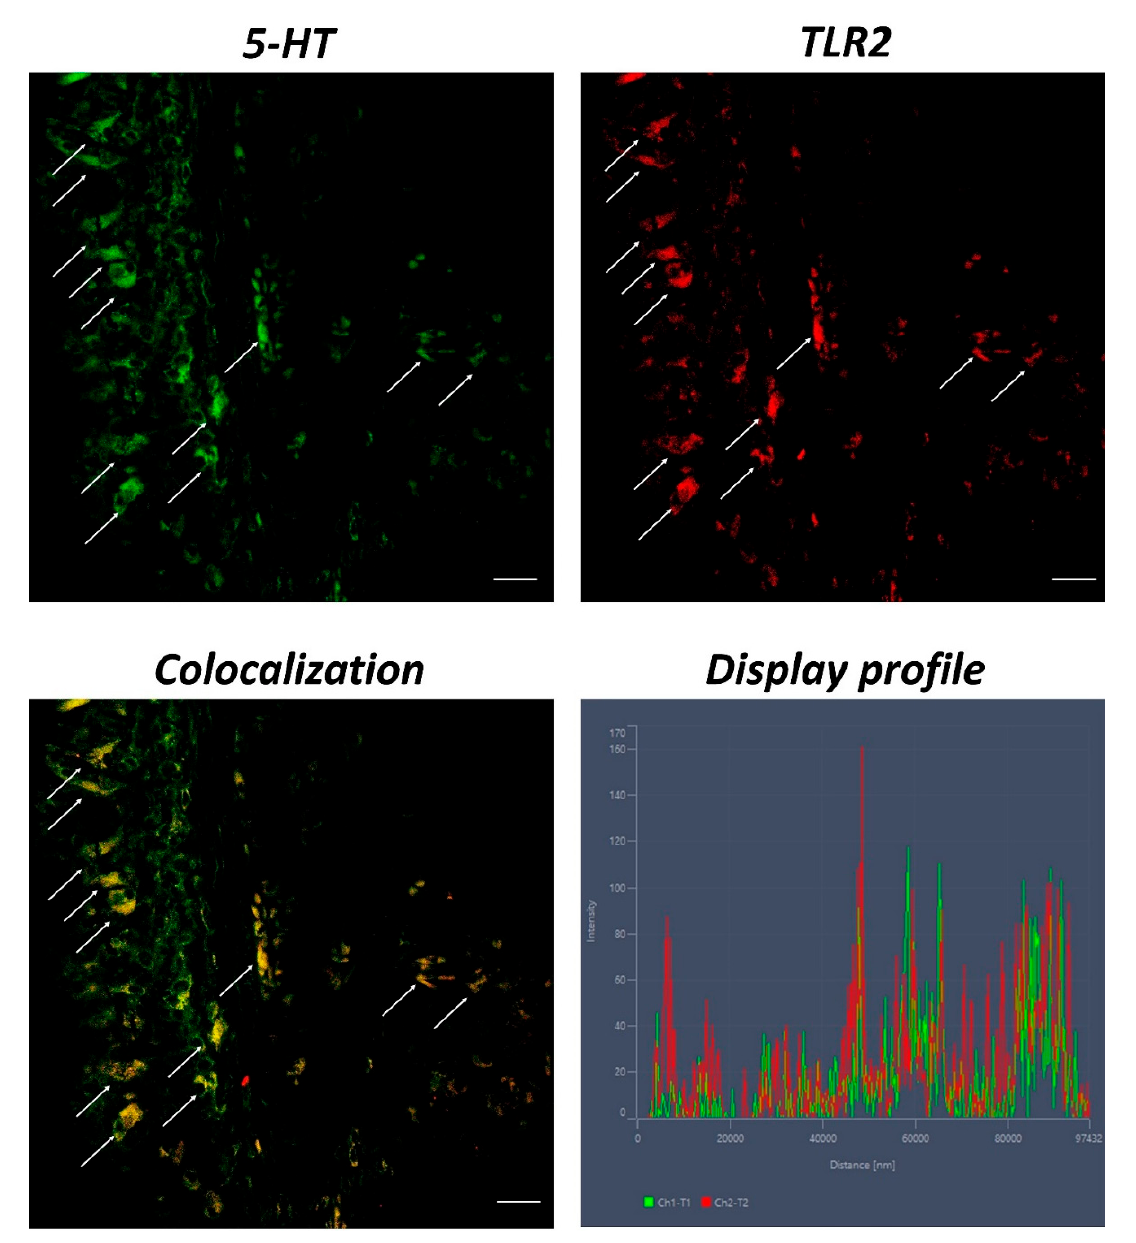
Figure 5. Section of the gill of giant mudskipper, immunofluorescence of 5-HT and TLR2, 40×, scale bar 40 μ m. Scattered MCs positive to 5-HT (green) and TLR2 (red) are evident (arrows). The colocalization of the antibodies is clear and confirmed by the ‘display profile’ function. Table 1. Quantitative analysis results (mean values ± standard deviations; n =